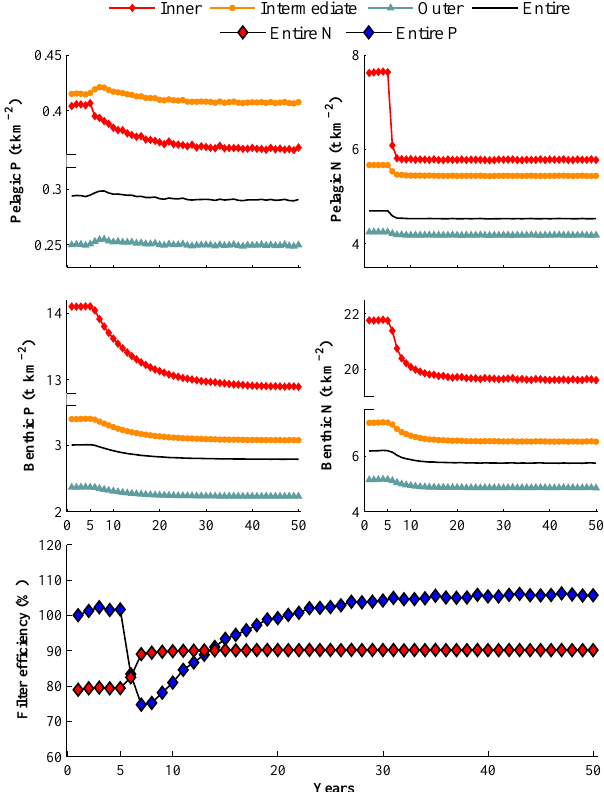
Figure 14. Pelagic (upper) and benthic (middle) pools of P (left) and N (right) in the inner (red), intermediate (orange), outer (turquoise) and entire (black) Stockholm Archipelago. The filter ef- ficiencies (%) of N (red) and P (blue) load from land and atmo- sphere are shown for the entire Stockholm Archipelago (lower), where the small peaks derive from leap